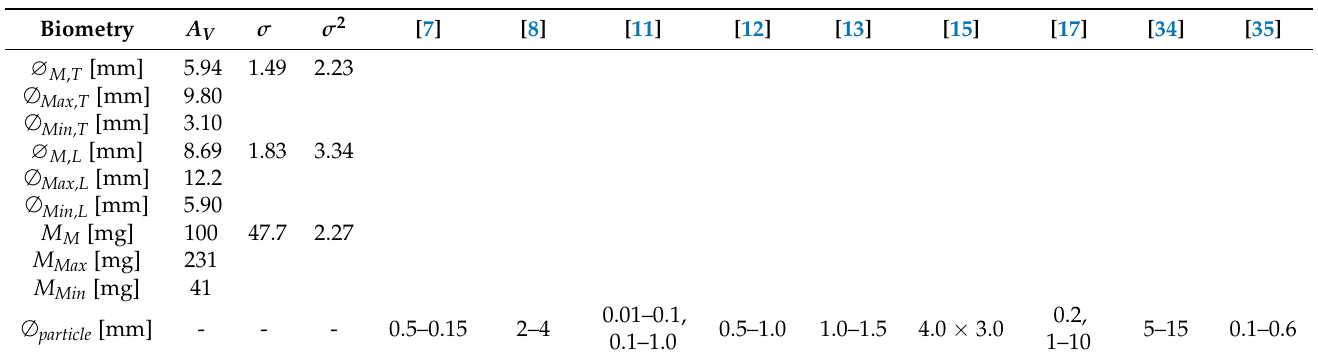
Table 1. Biometry of cross-linked PMMA-based dental resins scraps, average particle transversal ∅ ∅ M , T and longitudinal M , L diameters and M M mass, maximum particle transversal ∅ Max , L longitudinal diameters and M Max mass, minimum particle transversal longitudinal diameters and M Min mass, of particles aggregate, and ∅ Particle particle sizes of virgin and filled PPMA reported in the literature